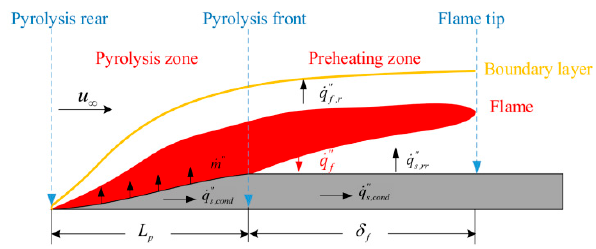
Figure 21. Concurrent-flow flame spread and definition of flame length [151]. Figure 17. Concurrent-flow flame spread and definition of flame length